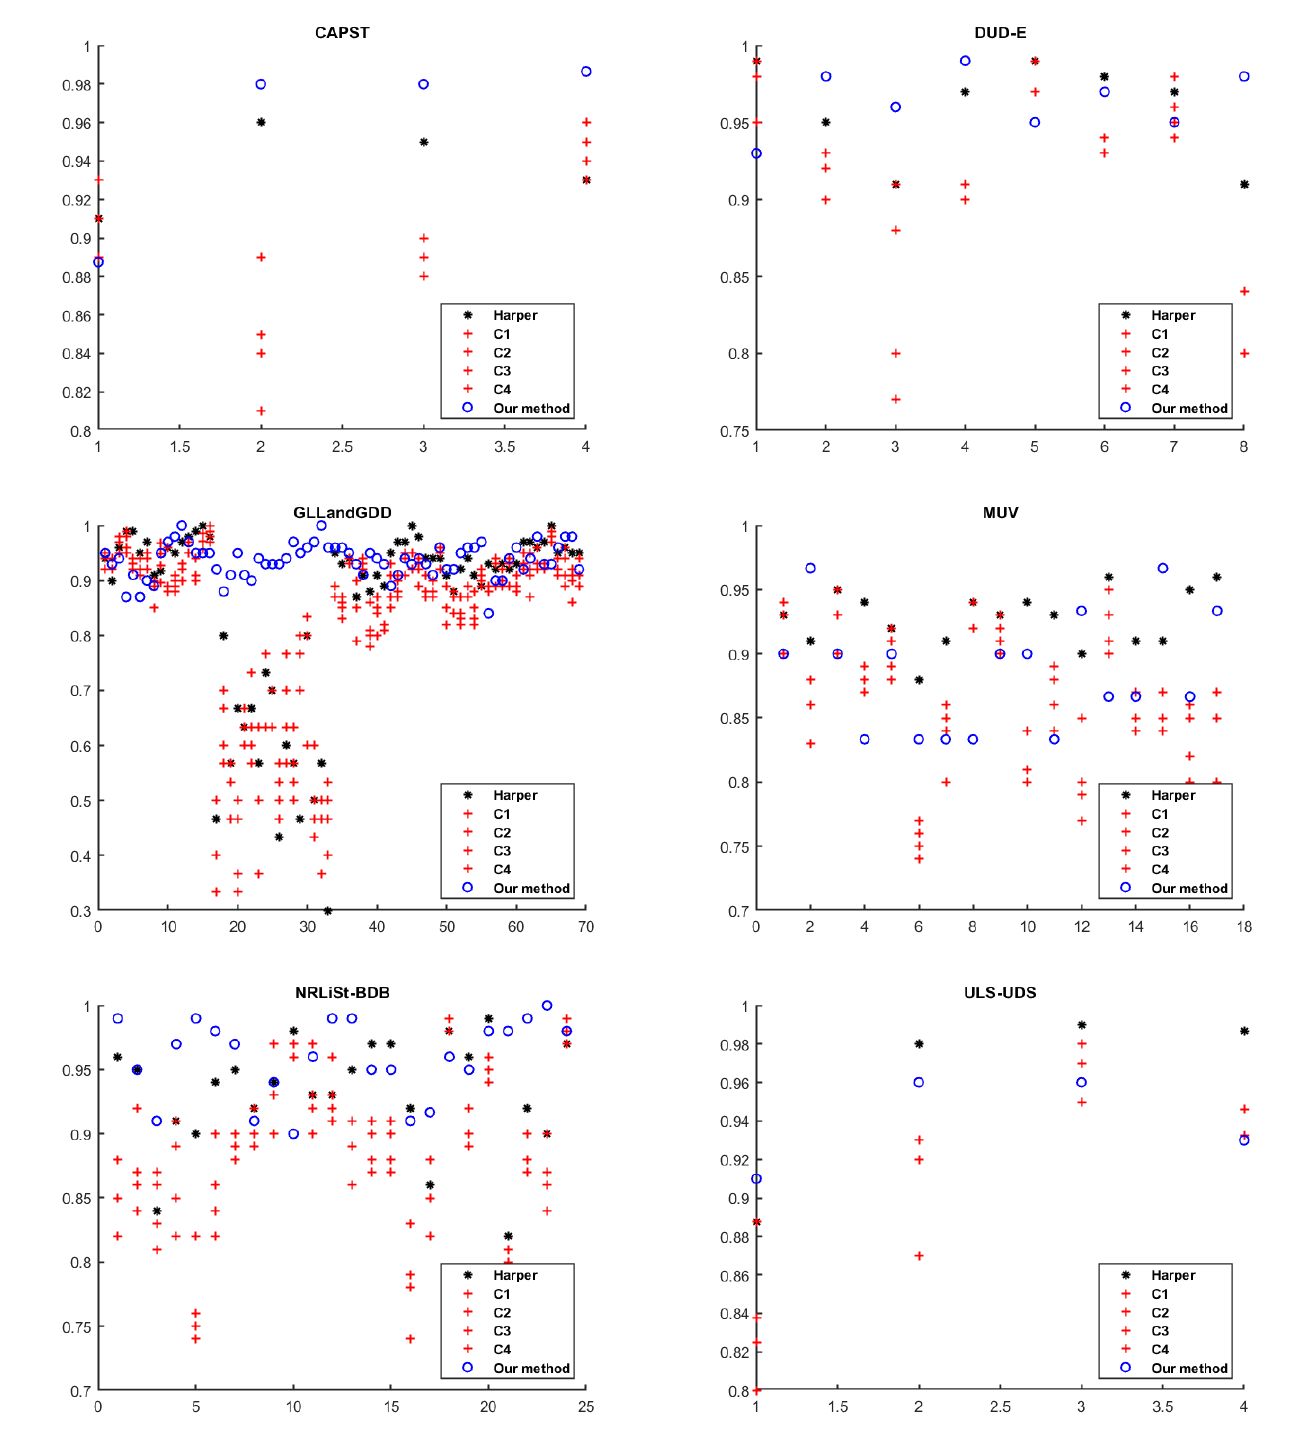
Figure 5. Classification ratio in the test set over the 127 targets available in the six datasets. The horizontal axis represents the index of the targets presented in Table